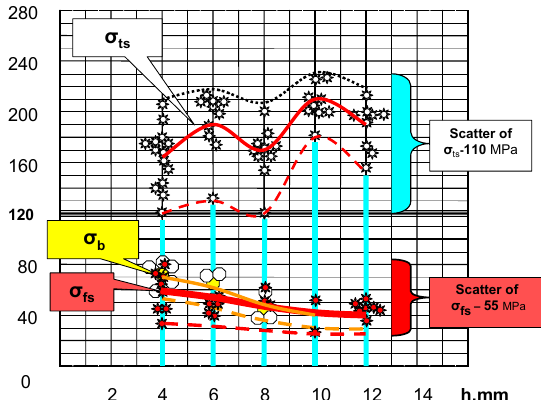
Figure 8. Fracture surface strength σ fs and bending strength σ b of tempered